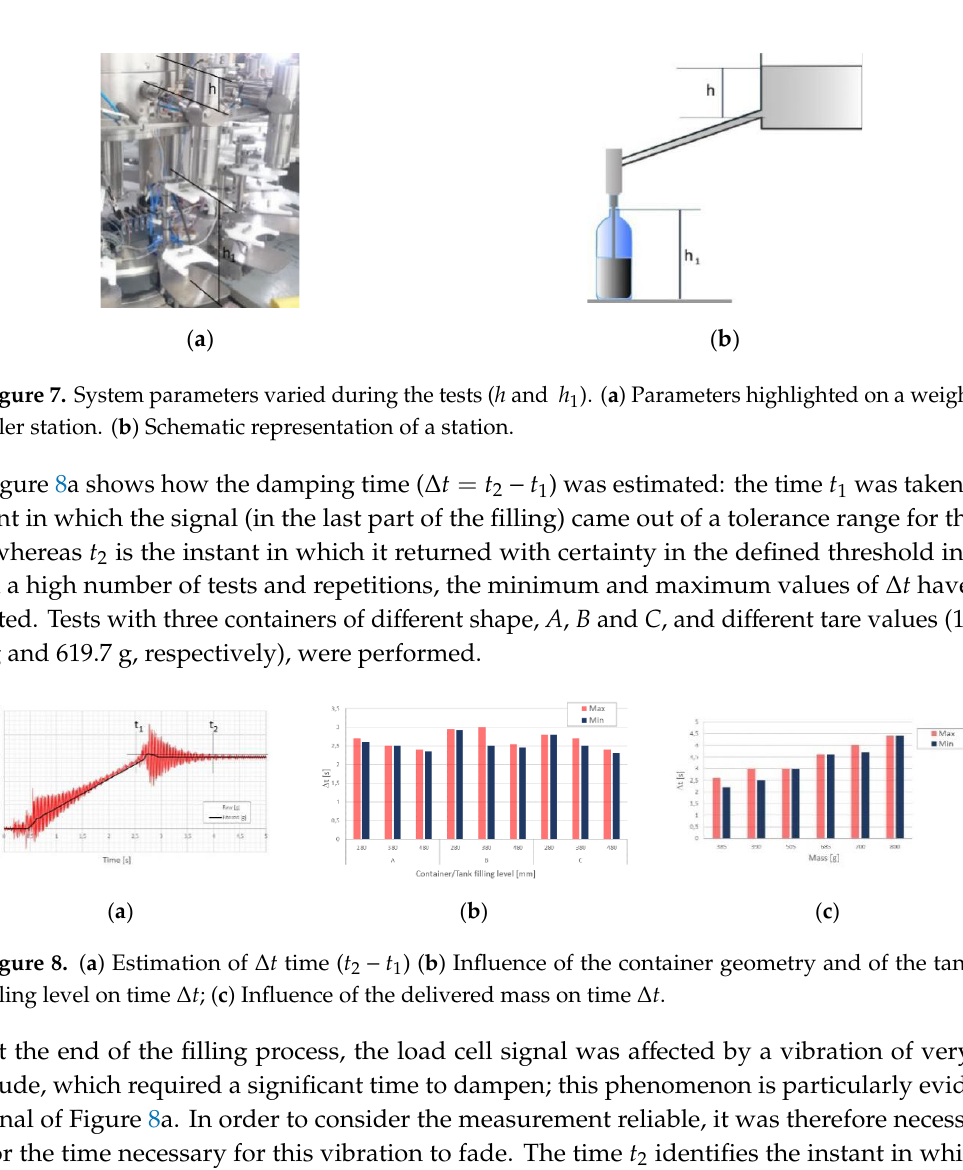
Figure 8. ( a ) Estimation of  t time ( 𝑡 2 − 𝑡 1 ) . ( b ) Influence of the container geometry and of the tank filling level on time  t; ( c ) Influence of the delivered mass on time  t.